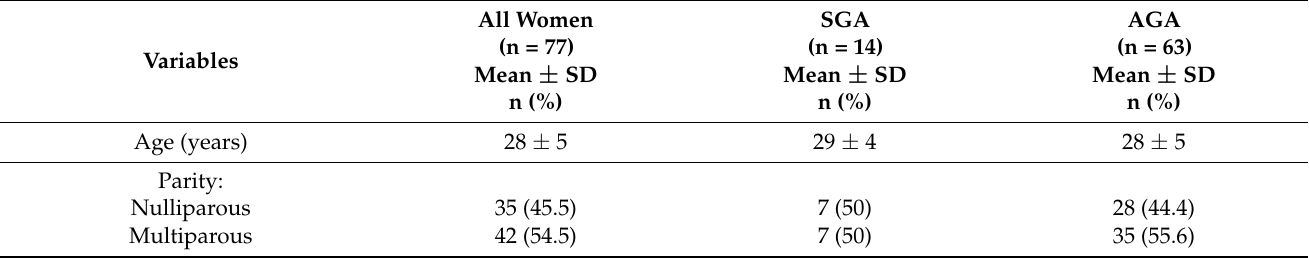
Table 1. First trimester maternal clinical and biochemical data and gestational age according to newborn weight for